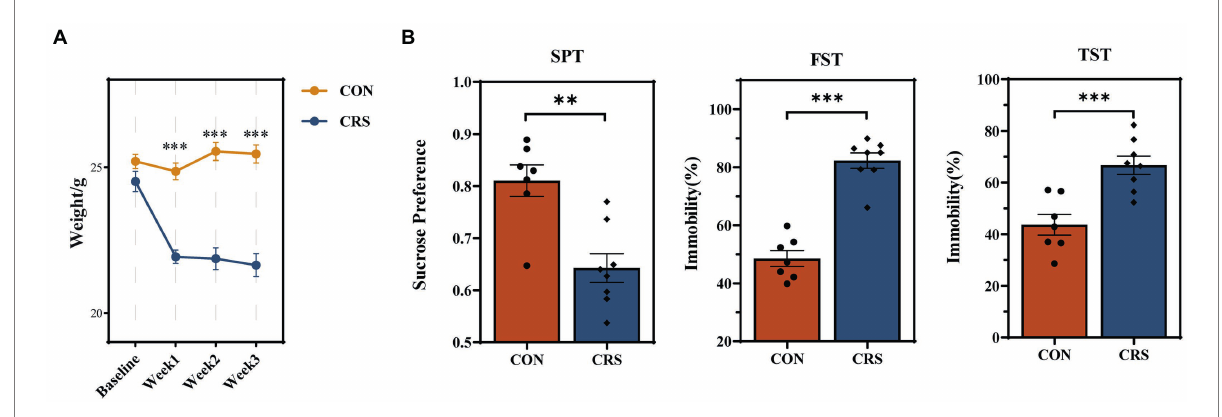
FIGURE 1 Behavioral results and body weight changes in mice during the experiment. (A) Weight changes per week from baseline to end of the study. (B) Behavioral results of sucrose preference test (SPT), forced swimming test (FST), and tail suspension test (TST). The data are represented as the mean ± standard errors of the means (SEM). ** p < 0.01, *** p <